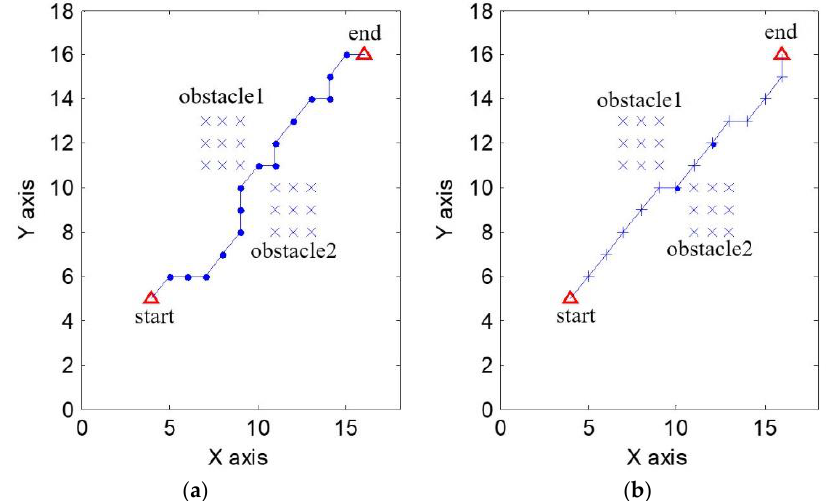
Figure 11. Optimal path with the ABC algorithm and the IABC algorithm: ( a ) optimal path with ABC algorithm; ( b ) optimal path with IABC algorithm.